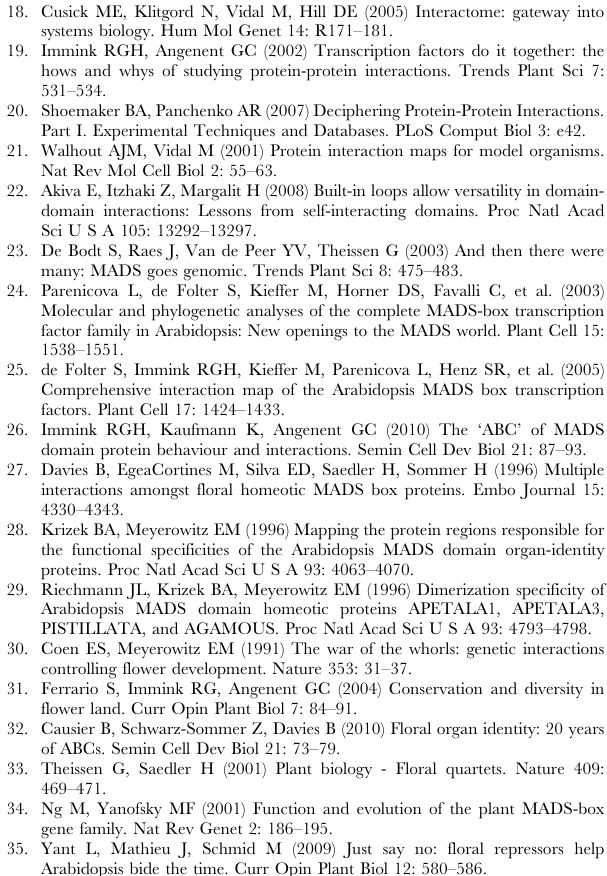
Table S7 Analysis of known mutations in MADS domain proteins.